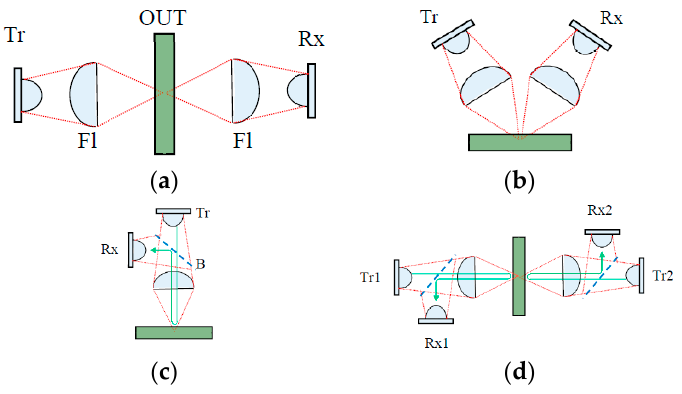
Figure 3. Geometries utilized in composite materials evaluation using pulsed terahertz imaging: ( a ) transmission setup; ( b ) reflection “V” setup; ( c ) reflection setup with beam splitter; and ( d ) proposed geometry-double-sided measurement using reflection setup.